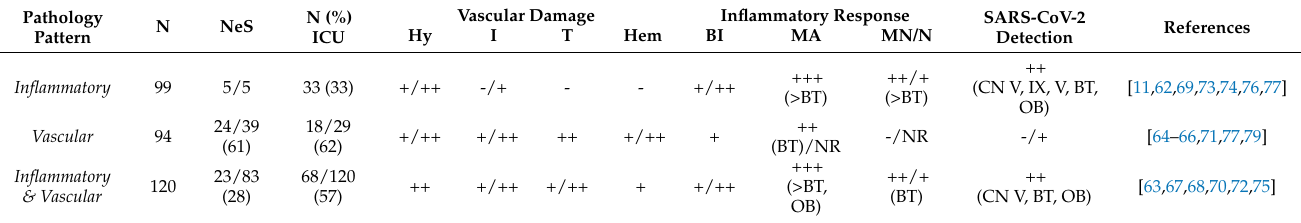
Table 1. Patterns of neuropathological findings in